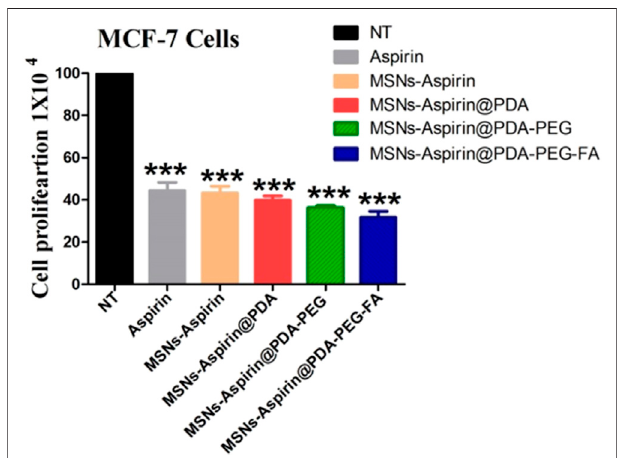
FIGURE5| ProliferationassayofMCF-7breastcancercellsexaminedat 72 h; cell culture is treated with negative control (NT), free drug (aspirin), drug- loaded in MNPs (MNP-Asp), and all other derivatives of aspirin-loaded MNPs prepared in this study (MNP-Asp@PD, MNP-Asp@PD-PG, and MNP- Asp@PD-PG-F).